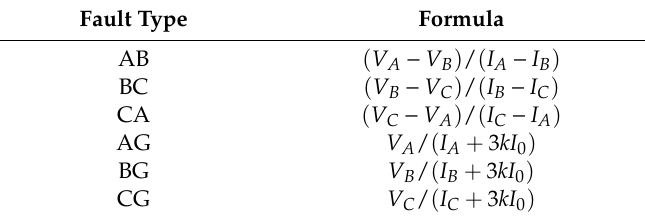
Table 1. Fault impedance calculation formula on di ff erence